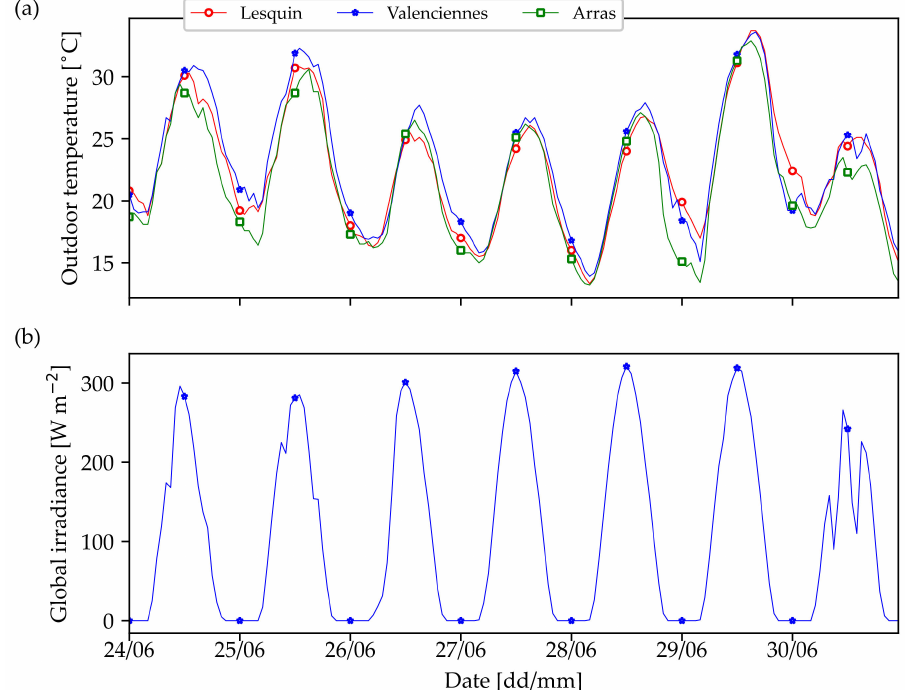
Figure 8. ( a ) Outdoor temperature representation of the three different M é t é o France weather stations: Valenciennes (50 ◦ 21 (cid:48) 36 (cid:48)(cid:48) N 3 ◦ 05 (cid:48) 24 (cid:48)(cid:48) E), Arras (50 ◦ 15 (cid:48) 36 (cid:48)(cid:48) N 2 ◦ 52 (cid:48) 12 (cid:48)(cid:48) E), and Lesquin (50 ◦ 20 (cid:48) 24 (cid:48)(cid:48) N 3 ◦ 04 (cid:48) 12 (cid:48)(cid:48) E) between 24 June 2019 and 30 June 2019. ( b ) Global downward irradiance of the Valenci- ennes (50 ◦ 21 (cid:48) 36 (cid:48)(cid:48) N 3 ◦ 05 (cid:48) 24 (cid:48)(cid:48) E) weather station between 24 June 2019 and 30 June 2019. The frequency distribution of wind speed and wind direction between 24 June 2019 and 30 June 2019 are presented in Figure 9 for different M é t é o France weather stations: Lesquin (a)–(b), Valenciennes (c)–(d), and Arras (e)–(f). The prevailing wind is North-East for the three cities. The mean wind speeds are between 4 and 4.5 m s − 1 for all locations. The most frequent wind speed is 4.5 m s − 1 for Lesquin (frequency 11.2%), 4.5 m s − 1 for Valenciennes (frequency 10.5%), and 4.8 m s − 1 for Arras (frequency 13.0%). As in the case of the temperature, the wind profiles of these three weather stations were very